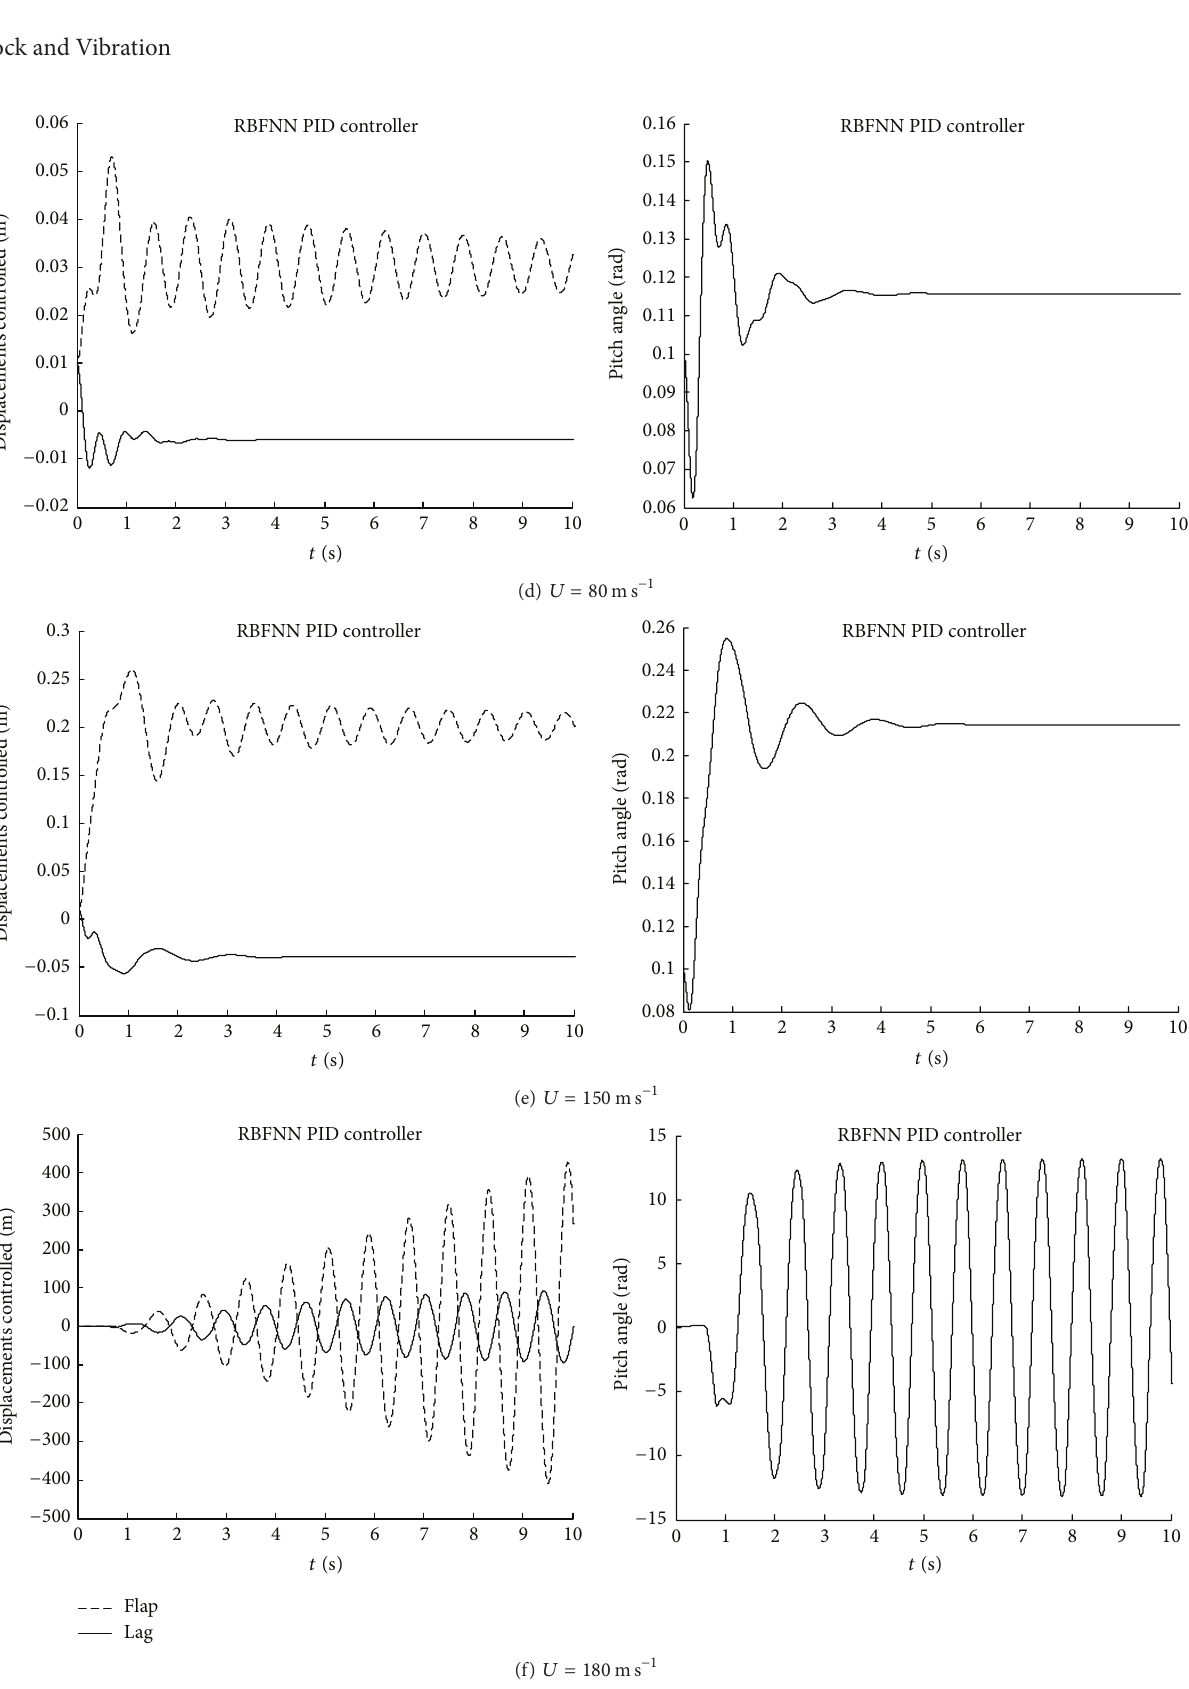
Figure 15: Flap and lag displacements and corresponding pitch angles of RBFNN PID control for 𝑈 = 50, 55, 60, 80, 150, and 180m s −1 ,